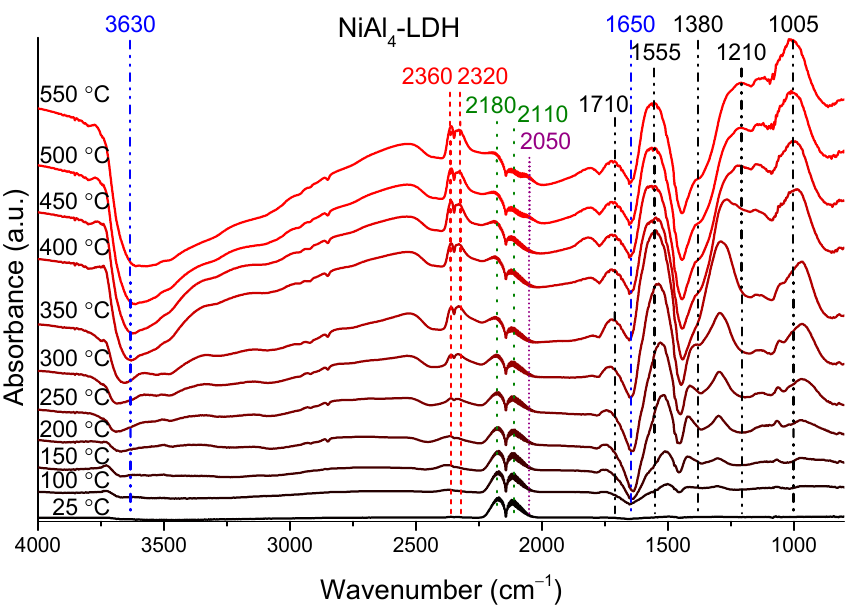
Figure 4. DRIFT spectra of the NiAl 4 –LDH, heated up to 550 °C in the presence of carbon monoxide– helium flow.